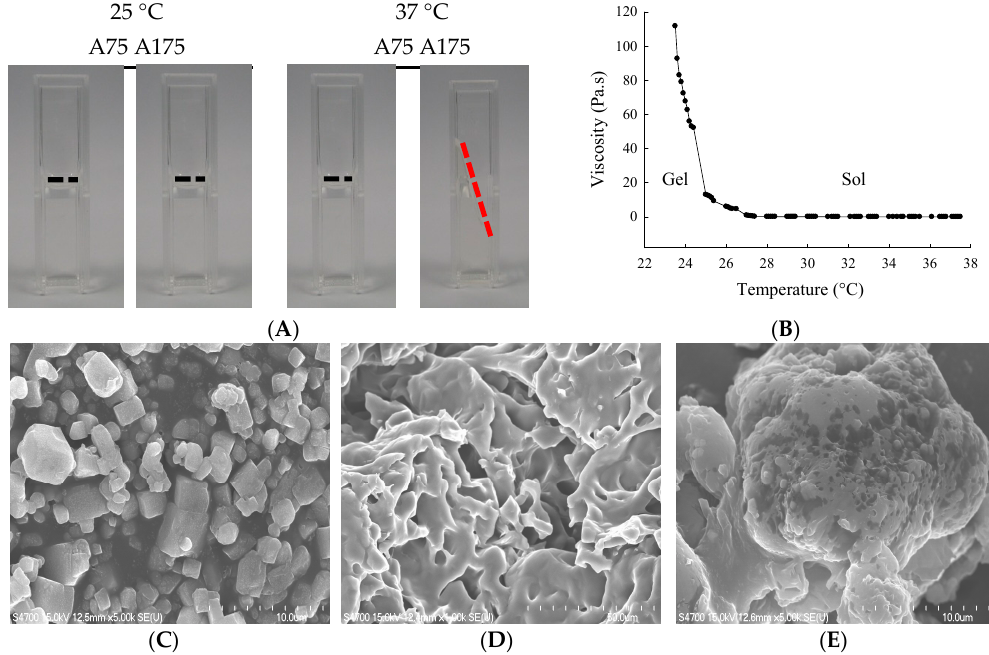
Figure 1. ( A ) Visual inspection of gelatin hydrogel at 25 °C or 37 °C; ( B ) Viscosity (Pa.s) vs. temperature for gelatin A175 hydrogel. Scanning electron microscopy (SEM) images showing microstructures of ( C ) epirubicin; ( D ) gelatin A175 hydrogel (H); and ( E ) epirubicin-loaded hydrogel (EPI-H). Magnification: (b,d) ×5000, (c) ×1000. Table 1. Characterization of gelatin hydrogel.